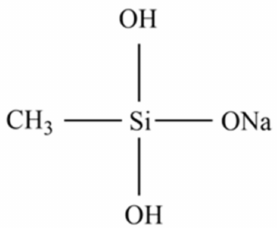
Figure 1. Chemical structure of Sodium methylsilicate.